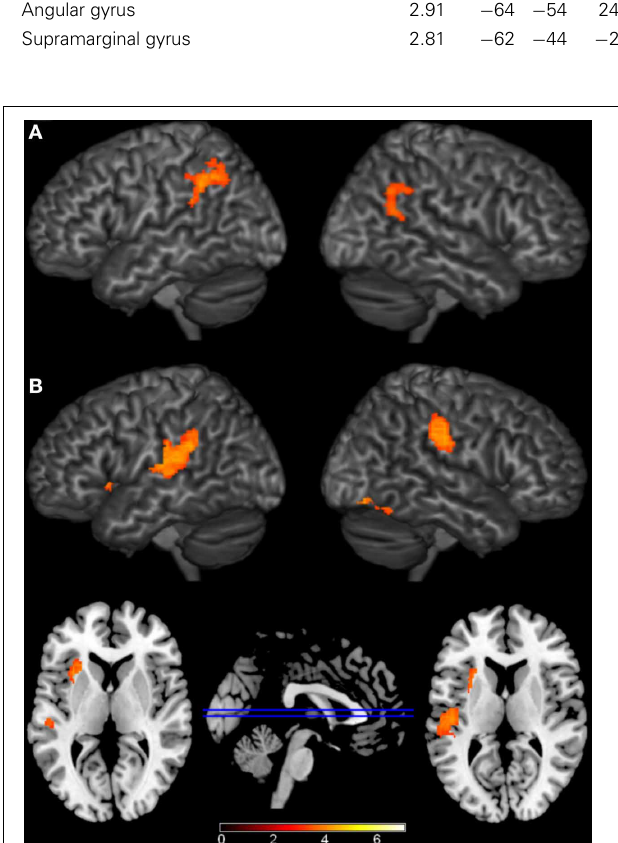
FIGURE 4 | Brain Activations to Naming Latencies. Areas where naming latencies to individual trials (i.e., the time it took each participant to name each object) were positively correlated with functional activation are shown in orange and represent areas where increases in activation are correlated with longer naming latencies. Significant activations were found in bilateral inferior frontal gyri (IFG), left insula, left posterior superior temporal gyrus (STG), and bilateral cingulate. Activations are scaled in terms of significant Z -values, and all comparisons are presented at a cluster-corrected threshold of p < 0 .